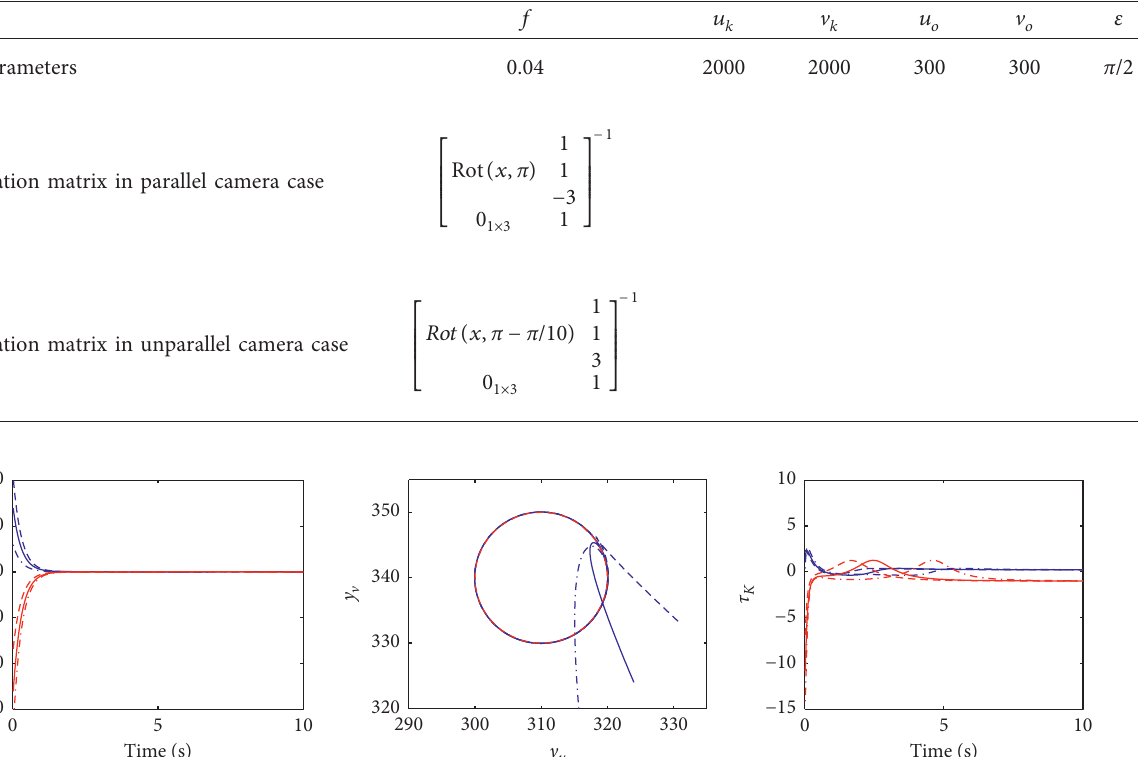
Table 1: Visual model parameters.